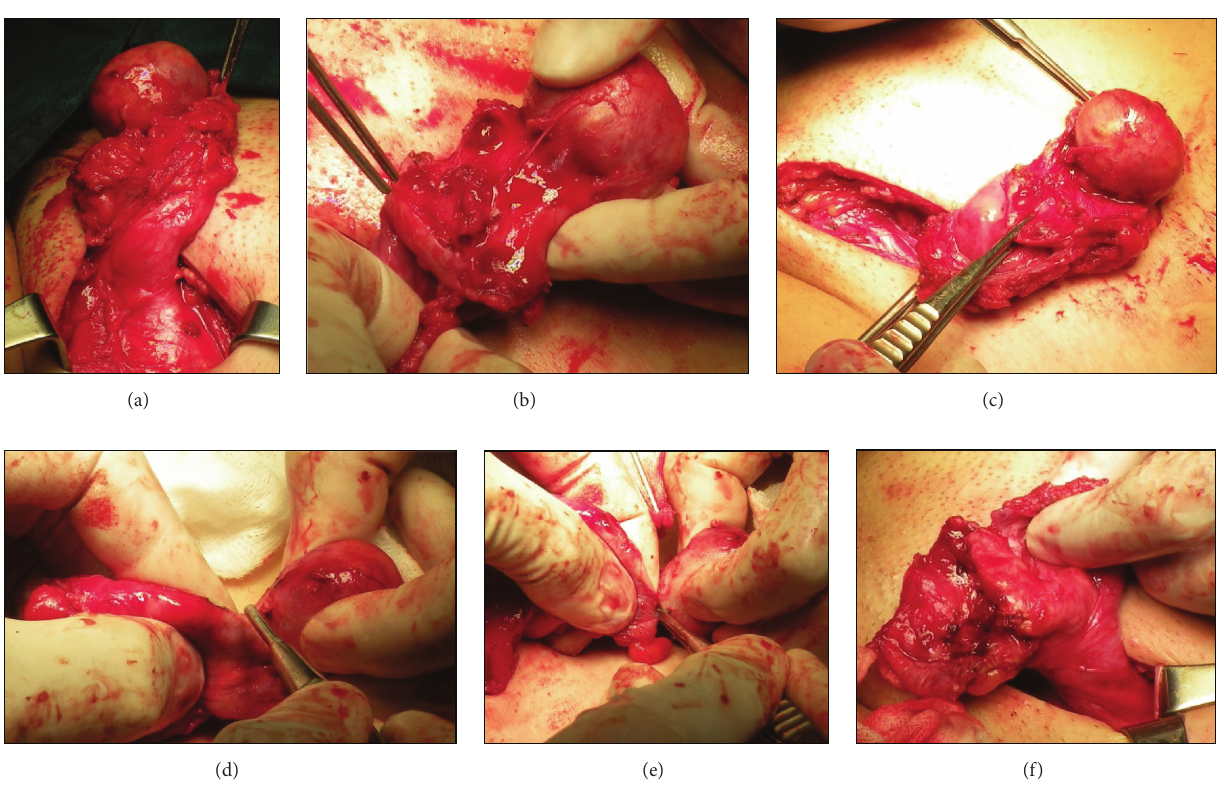
Figure 4: Intraoperative images . ((a)–(e)) Excision of the mass; (f) the mass is finally removed and the ovary-sparing surgery is